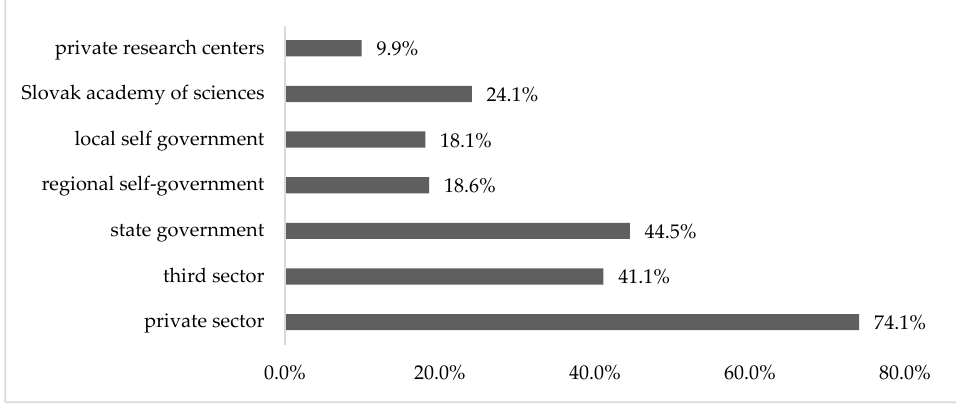
Figure 1. Share of academics engaged in application sphere by selected sectors .